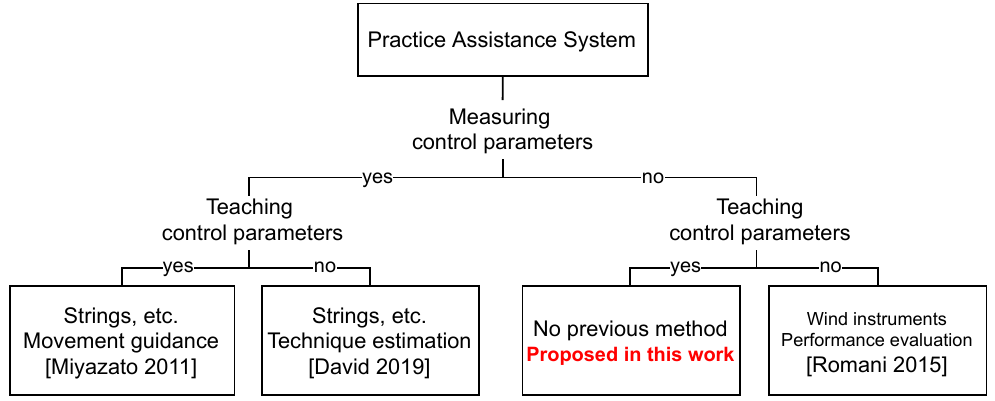
Figure 1. Classification of musical instrument practice assistance systems. In this study, we propose a new system that can provide movement teaching without the need to measure control parameters using